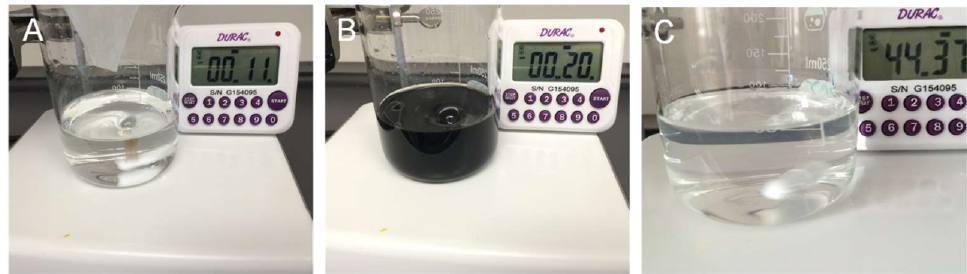
Figure 2. Photographs of the experimental process of Bi(NO 3 ) 3 reduction with NH 3 BH 3 without rGO support.( A ) Bi(NO 3 ) 3 solution in the ethylene glycol, ( B ) NH 3 BH 3 added in the solution, ( C ) Continuous stirring for approximately 45 min.